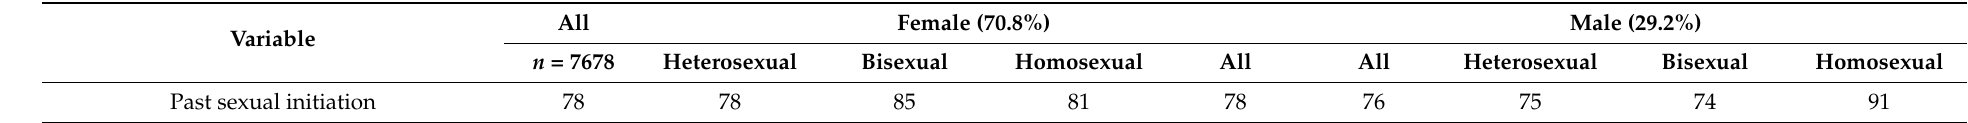
Table 2. Characterization of the sexual initiation among all respondents. All data contained in the table are presented as a